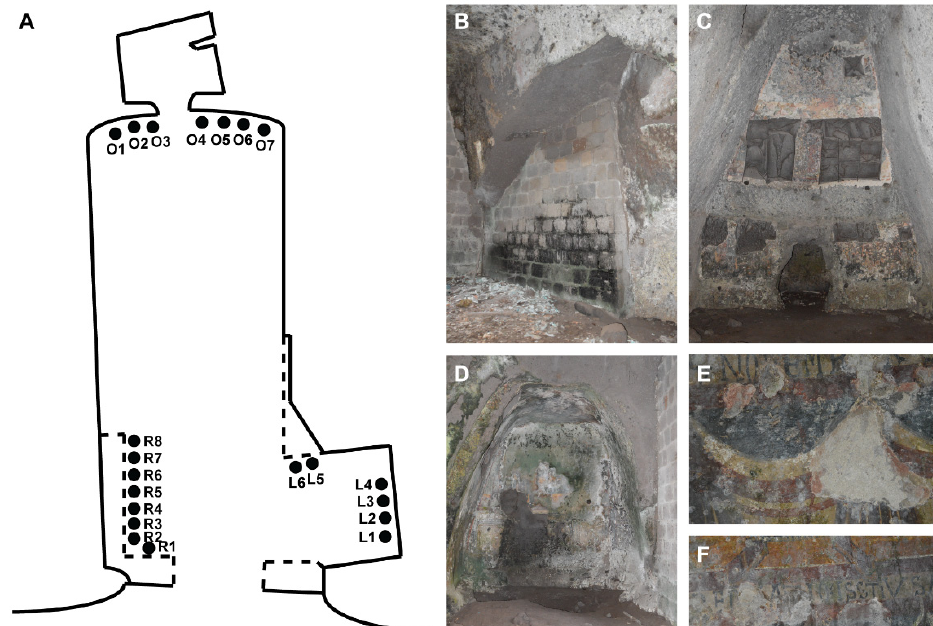
Figure 1. The Fornelle cave in Calvi Risorta. ( A ) Schematic representation of the cave (redrawn from [24]), indicating the sampling points (R = tuff rock; L = light fresco; O = dark fresco); ( B ) left side of the cave; ( C ) end wall of the cave; ( D ) end wall of the chapel (right side of the cave); ( E ) and ( F ) details of the frescoes on the left side of the chapel. Table 1. Sampling points at Fornelle cave, with measures of corresponding environmental parameters on the tested samples.